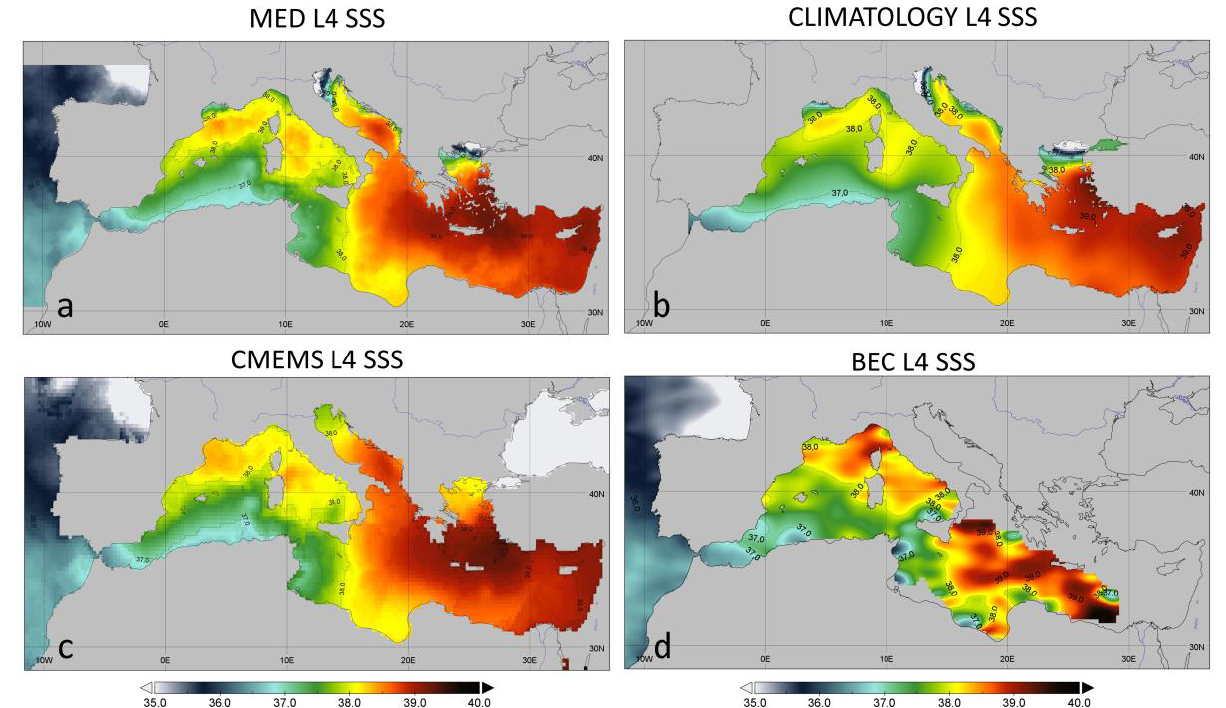
Figure 2. ( a ) Example of daily new Med L4 SSS field (20 April 2016); ( b ) in situ monthly climatology (April); ( c ) weekly CMEMS L4 SSS product (centered on 20 April 2016); and ( d ) corresponding daily BEC L4 SSS product (20 April